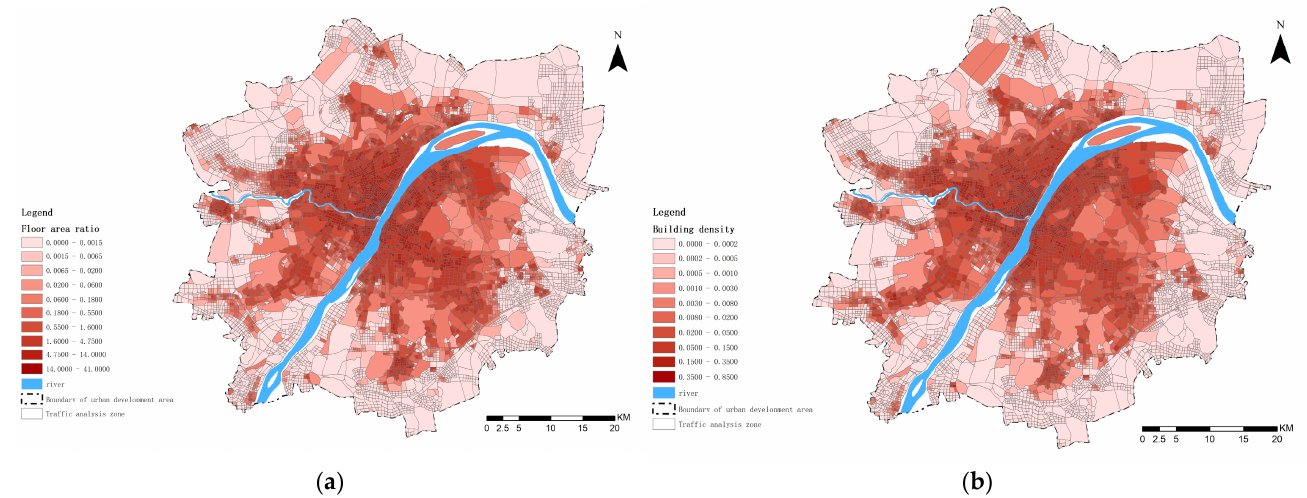
Figure 9. Spatial form: ( a ) Floor area ratio; ( b ) Building density.